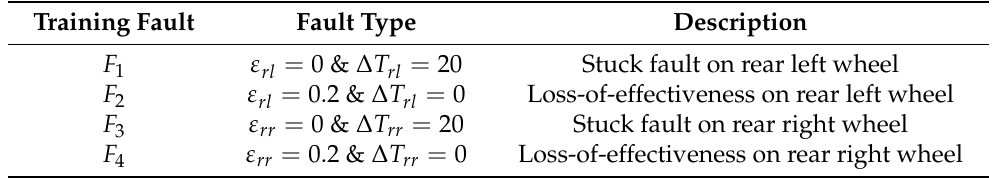
Table 2. Fault types used during training.